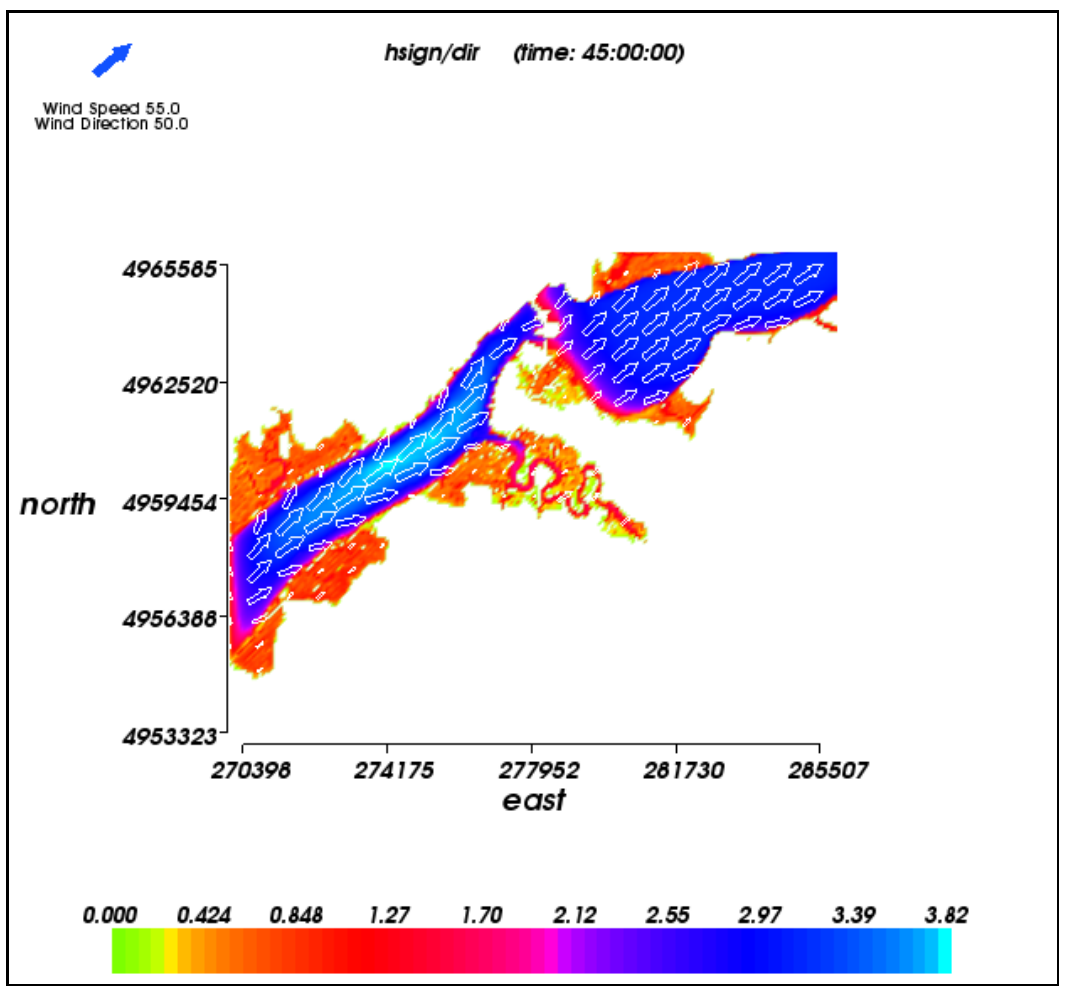
Figure 4. Results from the SWAN wave model. The model represents the maximum significant wave heights generated for winds from Greenwood, NS, February 1–3, 1976 and a water level set to 4.1 m, which represents the predicted tide. The colors represent the significant wave height (m) and white arrows represent the direction and size of the waves. The blue arrow in the upper left represents the speed (km/hr) and direction of the wind. Coordinates along the side are UTM Zone 20 NAD83 easting and northing